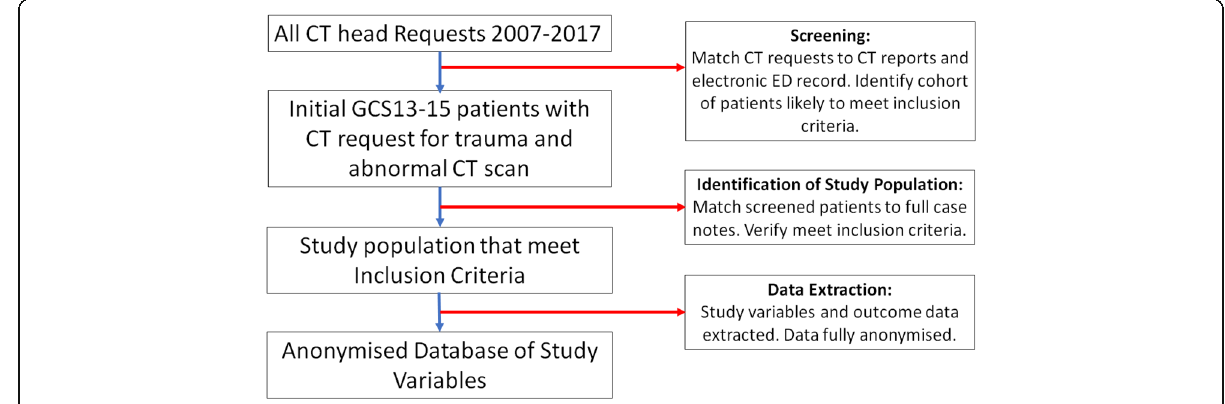
Fig. 2 Population screening and